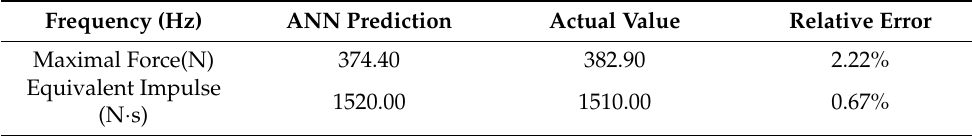
Table 5. Relative error of the impact load identification results.